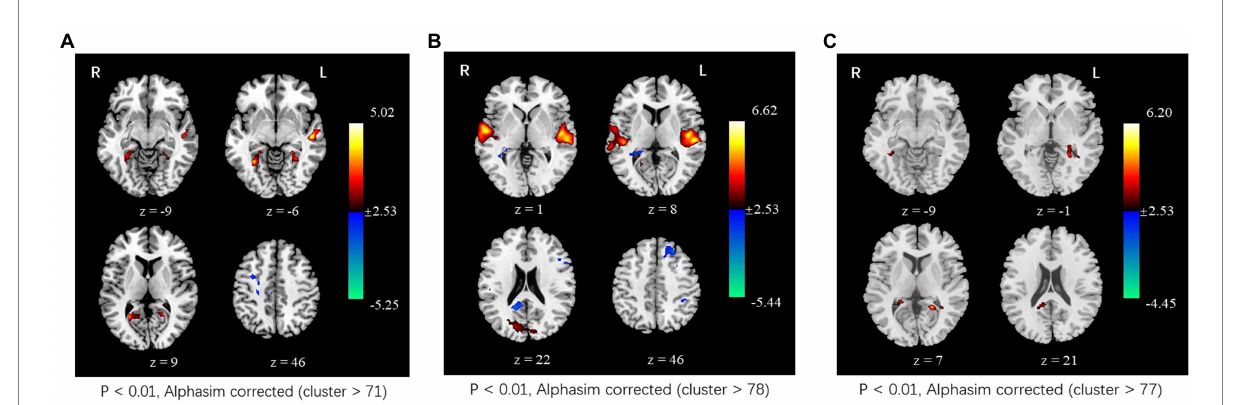
FIGURE 3 Changes in spontaneous neural activity induced by tcVNS. (A) Comparison results of ALFF between concurrent tcVNS stimulation and rest in the tcVNS group ( p < 0.01, AlphaSim corrected, cluster >71). (B) Comparison results of ALFF between concurrent sham stimulation and rest in the sham group ( p < 0.01, AlphaSim corrected, cluster >78). (C) Comparison results of ALFF between the tcVNS and sham groups ( p < 0.01, AlphaSim corrected, cluster >77).